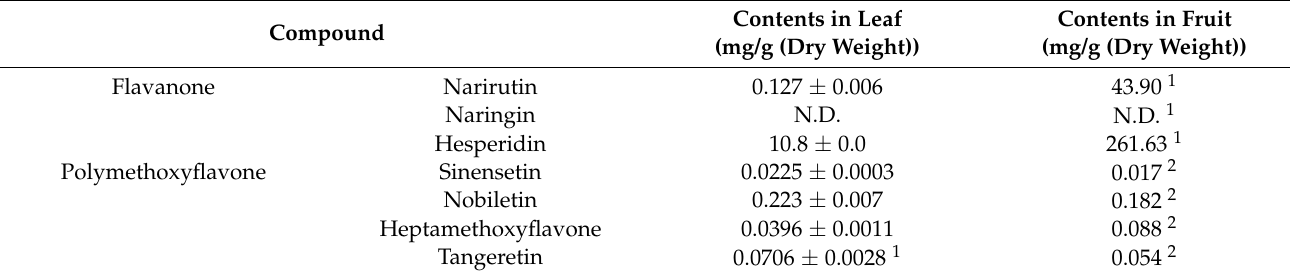
Table 1. The contents of flavanones and polymethoxyflavones in Citrus unshiu leaf and fruit.